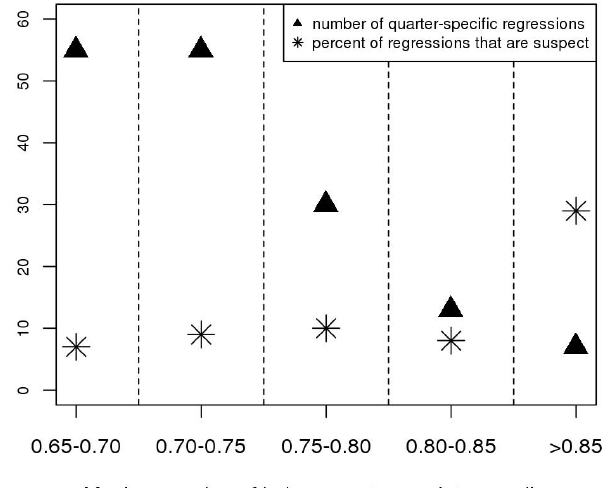
Fig. 4. Empirical selection of the 0.85 threshold | r P | value for iden- tifying site- and quarter-specific regressions which may be biased due to multicolinearity. See Sect. 2.4.1 for an explanation of what constitutes a regression that is “suspect.” The 452 EiV regressions with max | r P | < 0 . 65 were not examined when determining this em- pirical threshold.